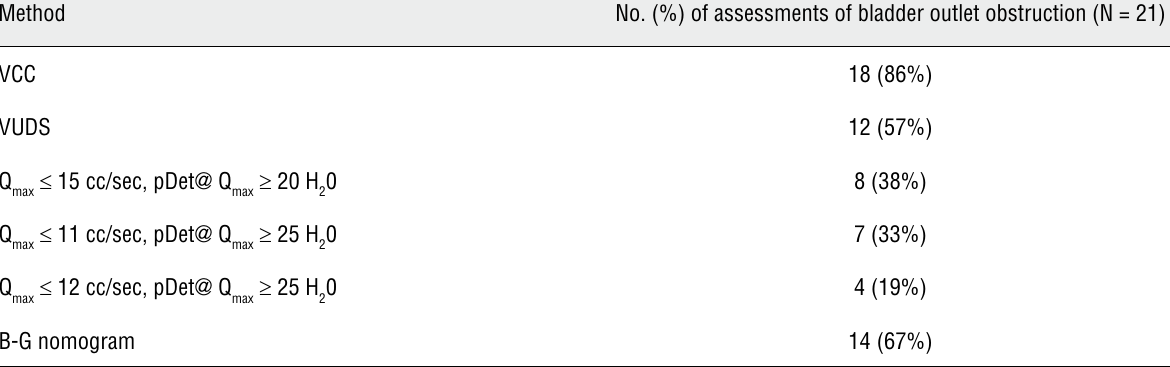
Table 1 - Assessment of bladder outlet obstruction by six different methods.